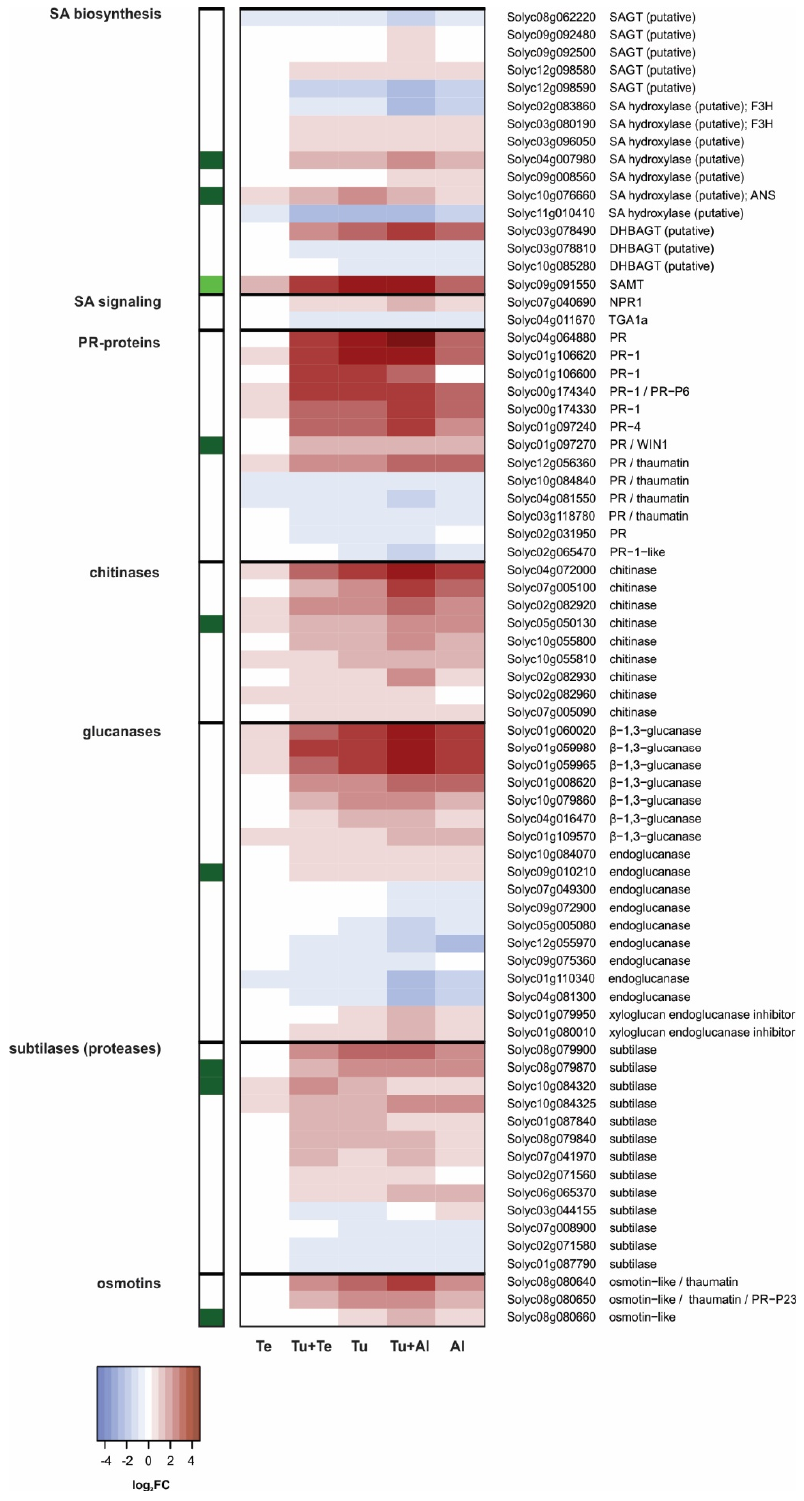
Figure 4. Gene-expression heat map depicting the relative transcript levels of tomato ( Solanum lycopersicum ) genes that encode proteins with a (predicted) function in the salicylic acid (SA) pathway and that were differentially expressed in leaves after seven days of infestation with herbivorous mites.